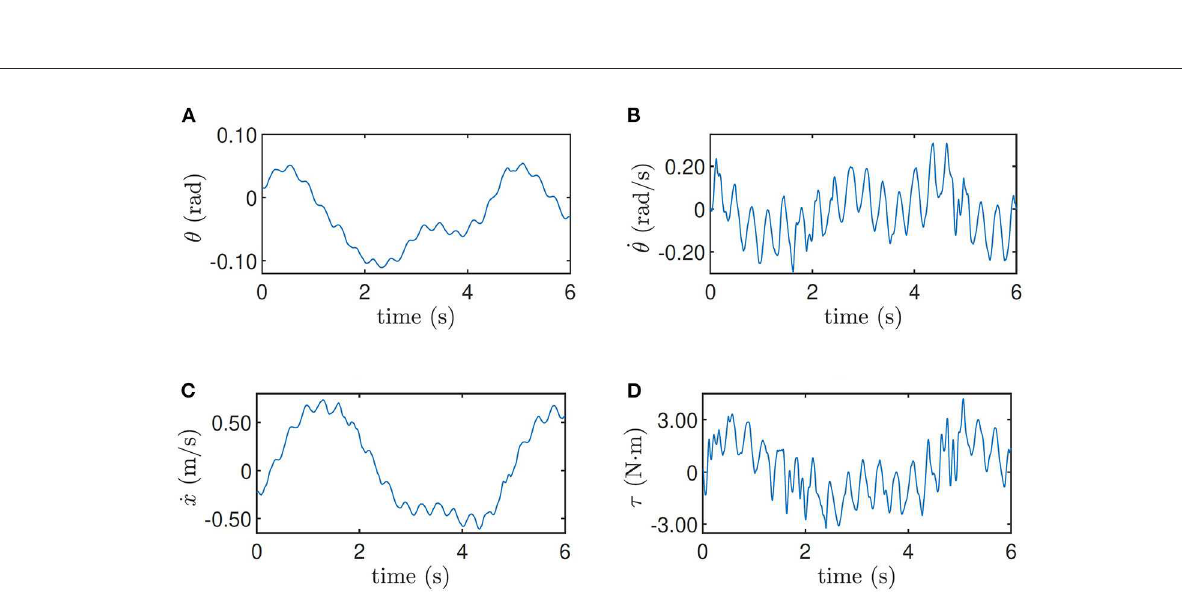
FIGURE5 Training data for height = 0.33 m. (A) Pitch angle θ , (B) pitch velocity ˙ θ , (C) line velocity ˙ x , and (D) input torque τ